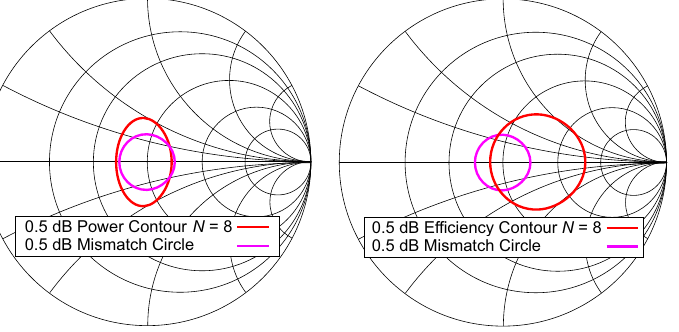
Figure 4. Comparison of 0.5dB power and efficiency contours for a N = 8 model with 0.5dB mismatch circles.